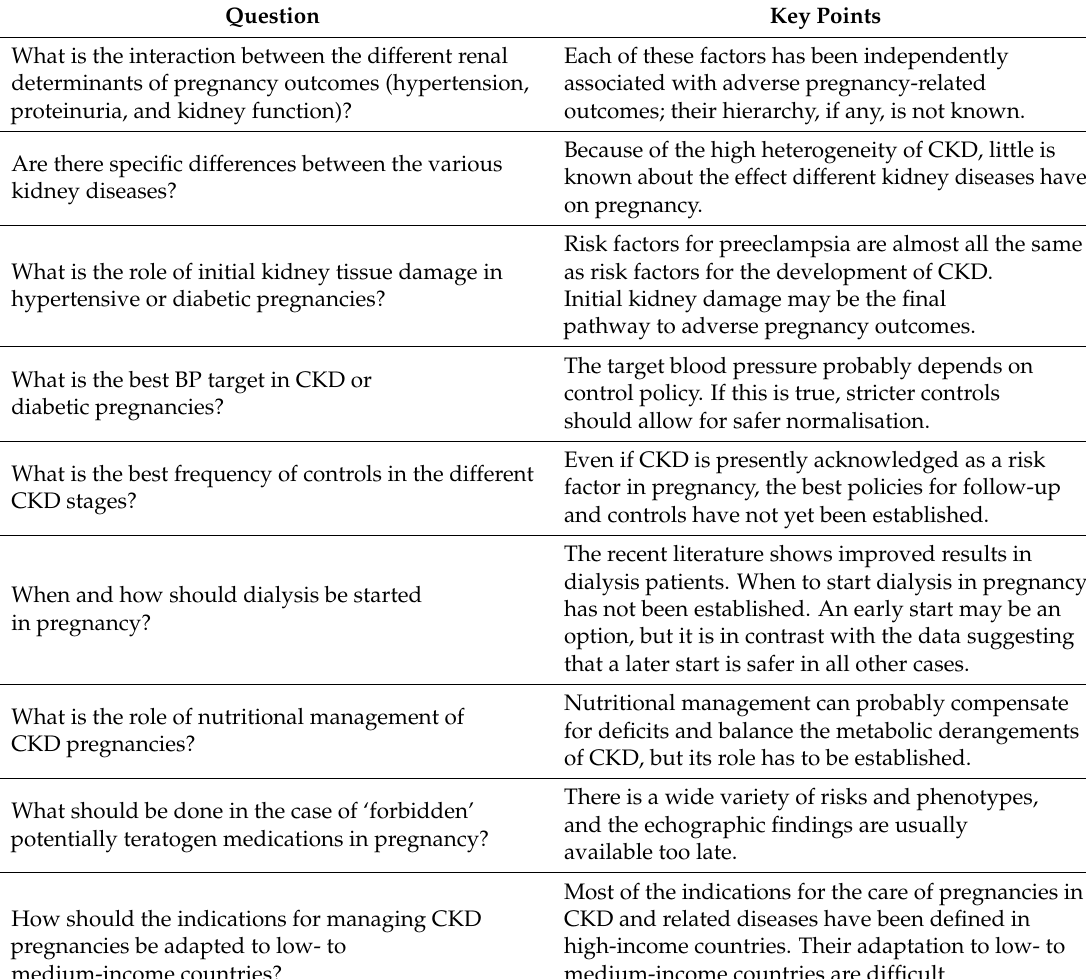
Table 2. Some clinical questions waiting for answers regarding pregnant women with